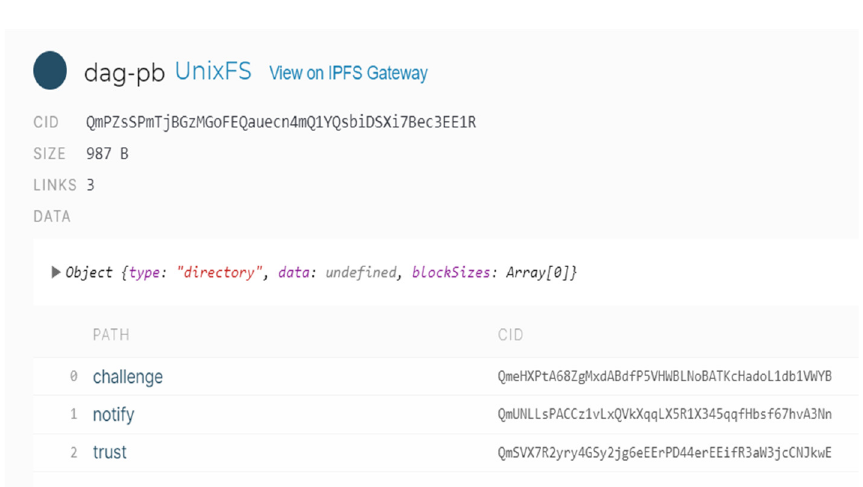
Figure 9. Interaction methods as unixfs.